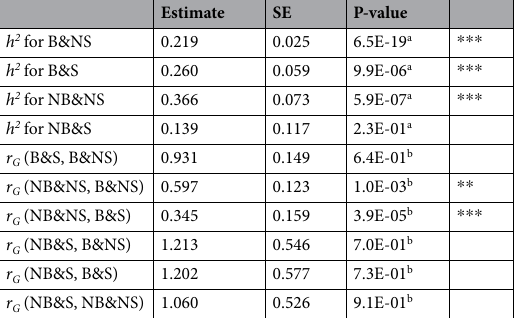
Estimate SE P-value